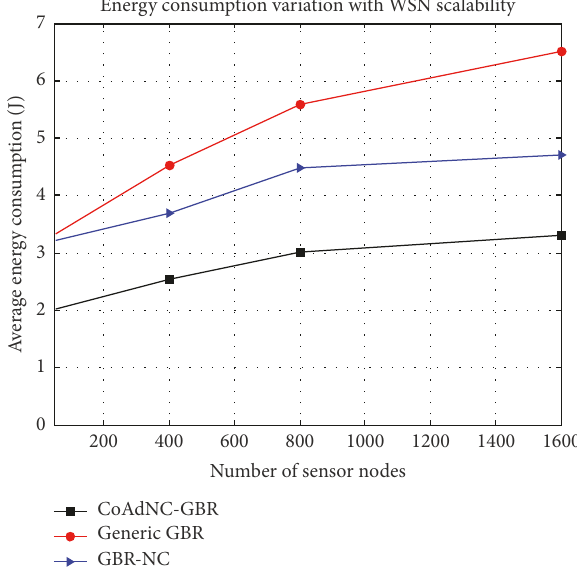
Figure 5: CoAdNC-GBR: average energy consumption and scala-